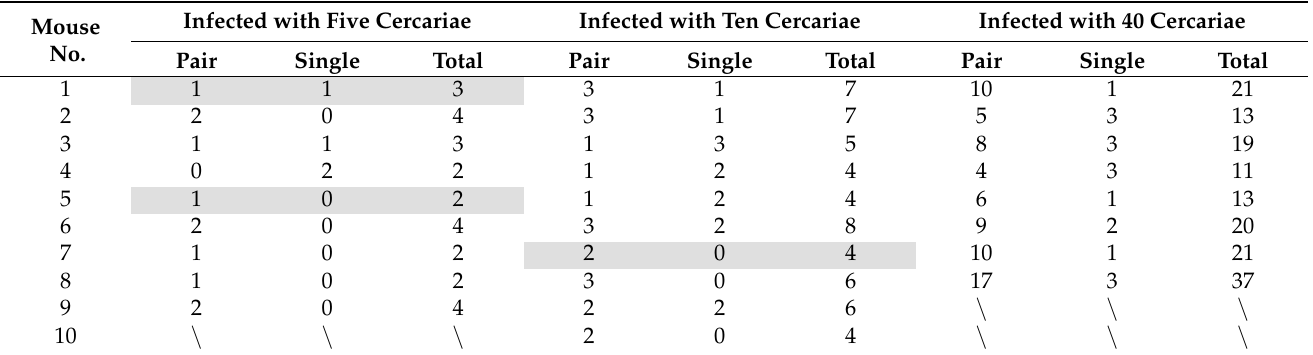
Table 2. The worm burden of each mouse infected with different amounts of